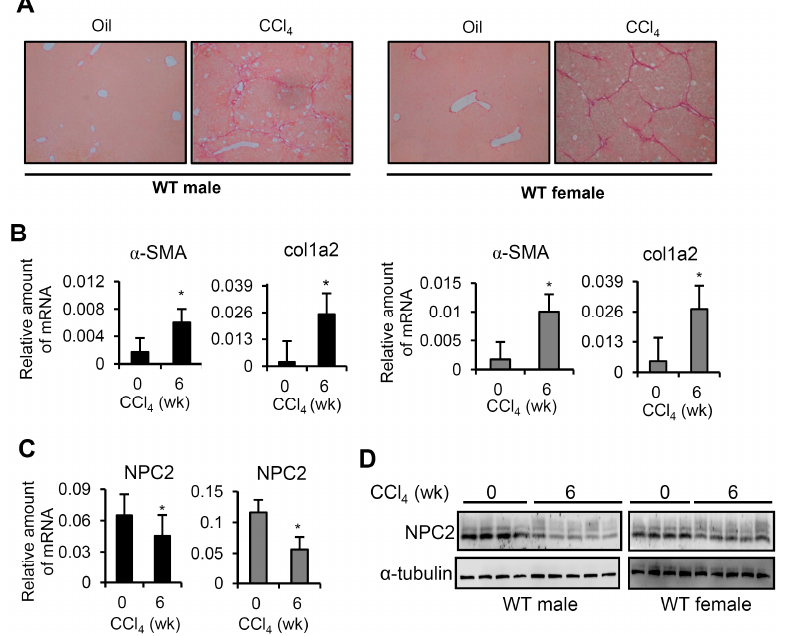
Figure 2. NPC2 is down-regulated in CCl 4 -induced liver fibrosis tissues. ( A ) Representative sirius red staining images of liver tissues from mice treated with CCl 4 for 0 and 6 weeks. Original magnification, ×100; ( B , C ) Results from Q-PCR analyses of α -SMA, Col1a2 and NPC2 gene expression in CCl 4 -treated WT male (black bar) and WT female (gray bar) mice; ( D ) Representative results from Western blot analyses of NPC2 expression in CCl 4 -treated WT mice. n = 5 per group. Data are shown as mean ± SD. * p < 0.05 vs. no CCl 4 treatment.